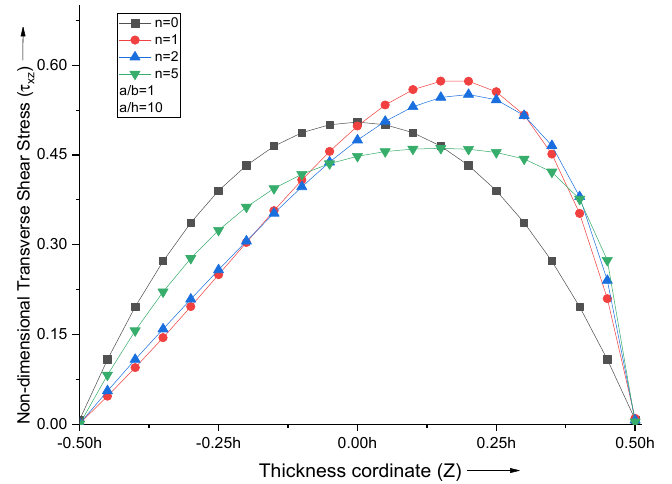
Figure 8. Effect of volume fraction index (n) on non − dimensional transverse shear stresses of the plate.